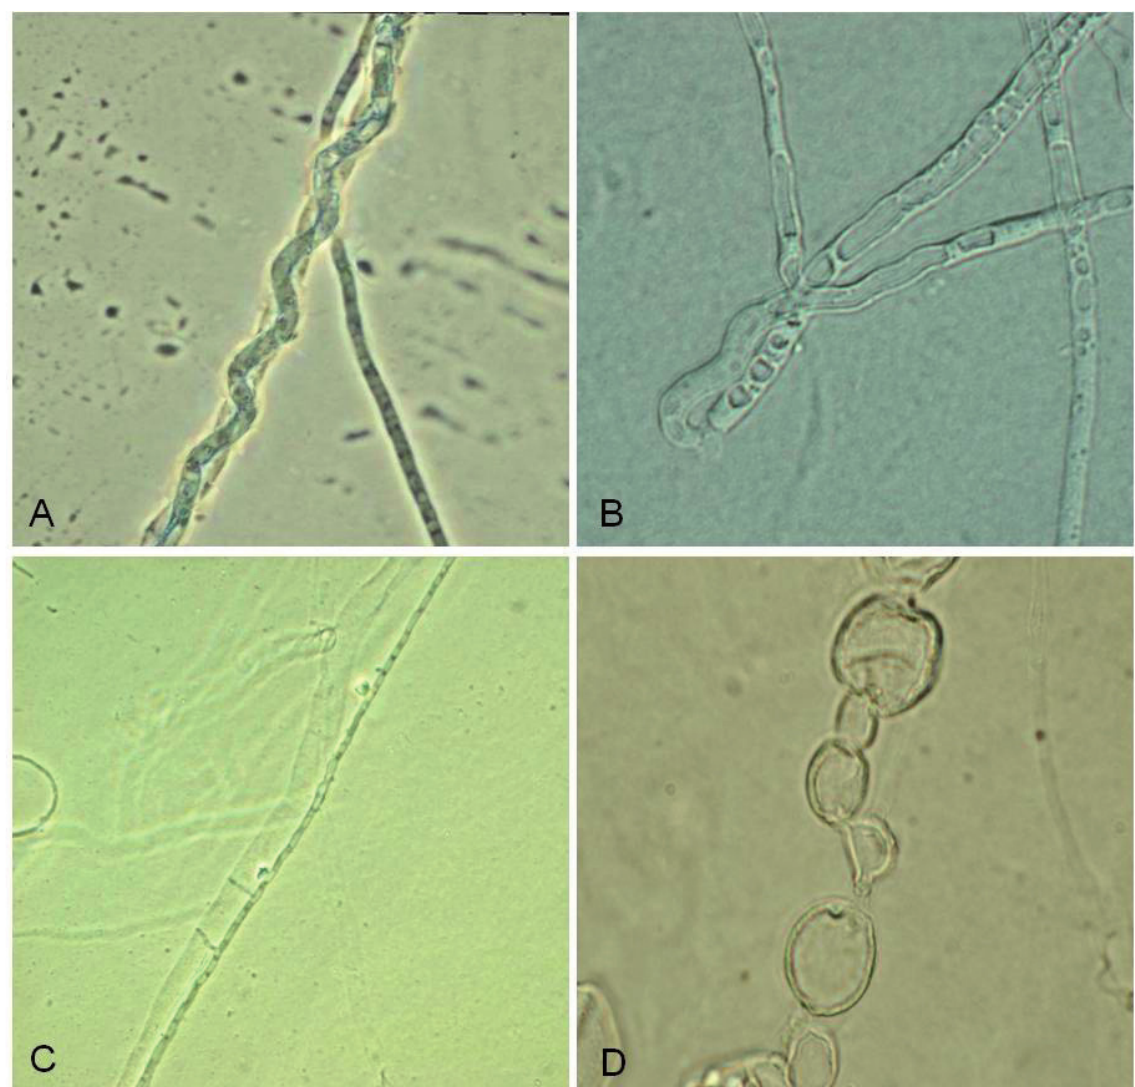
Figure 2. Microscopic interactions as observed at ×400 and ×1000 magnification. A) Coiling of Trichoderma hyphae around pathogenic hyphae as observed between USPP-T1 and L. theobromae (×1000). B) Hyphal disintegration of D. seriata hyphae (×1000). C) Hyphal adhesion observed between USPP-T1 and N. australe (×400). D) Hyphal swelling as observed in the interaction between B. subtilis and Ph . viticola